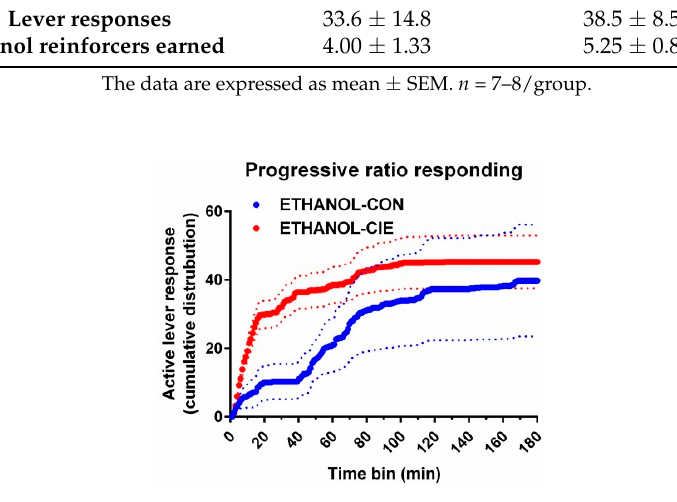
Table 3. Progressive-ratio breakpoints and number of ethanol reinforcers earned were not different between groups.